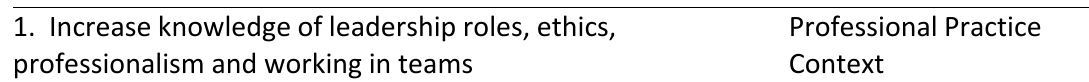
Table 1 Outcomes and Competency Domains Outcomes EVAL students